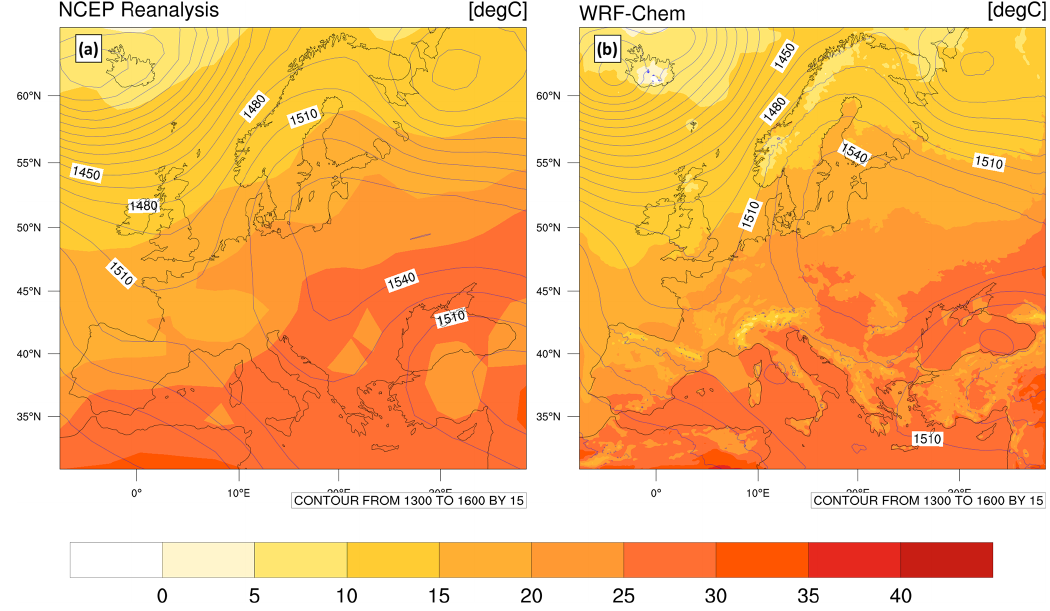
Figure 5. Comparison between the 6d (10–15 August 2015) average geopotential height (m) at 850hPa and mean temperature at 995hPa, obtained with (a) NCAR/NCEP reanalysis and (b) the WRF-Chem